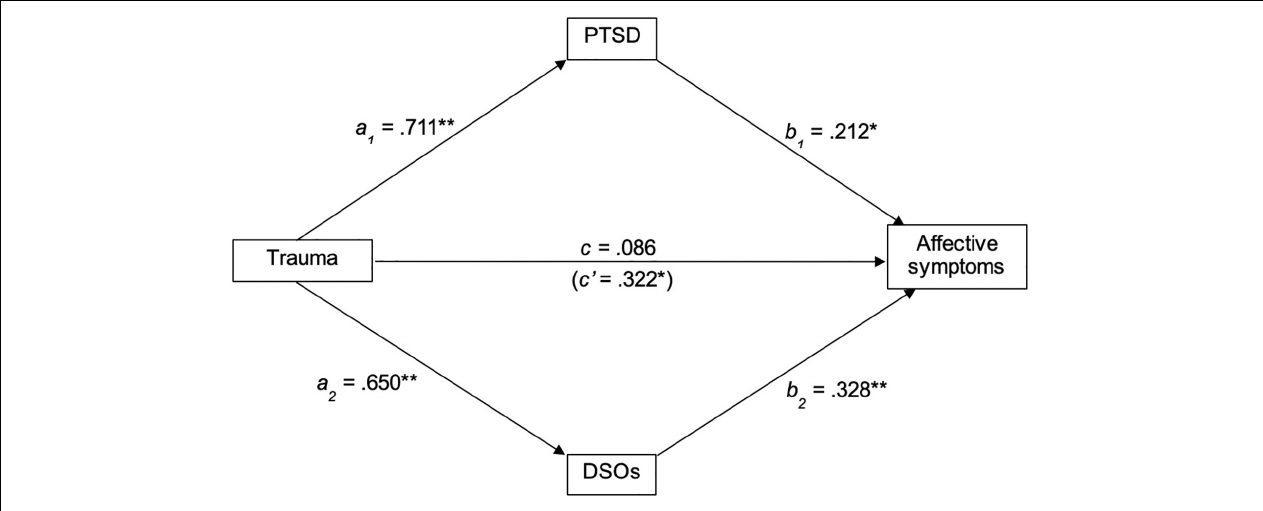
FIGURE 3 | Standardized regression coefficients for the relationship between trauma and affective symptoms, mediated by PTSD and DSOs. ** p < 0.005; * p < 0.05. PTSD, Post-traumatic stress disorder, DSOs, Disturbances of